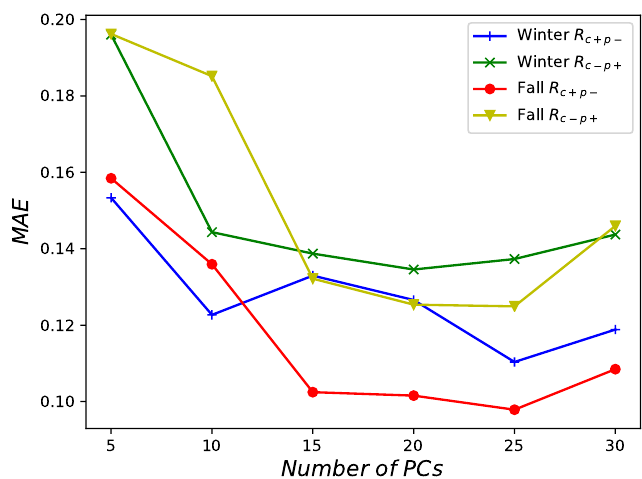
Figure A1. Mean absolute error (MAE) between the real and reconstructed risks normalized by the climatological risk as a function of the number of PCs used to fit the indexes I Pr and I Co in Equation (4).